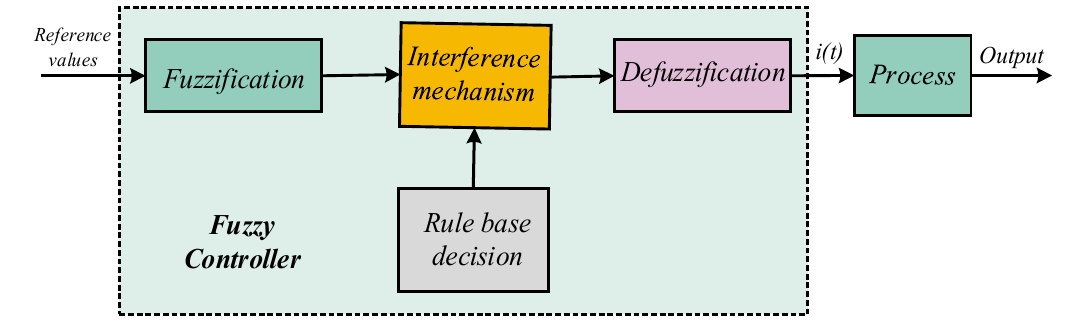
Figure 29. Block diagram of Fuzzy control algorithm.